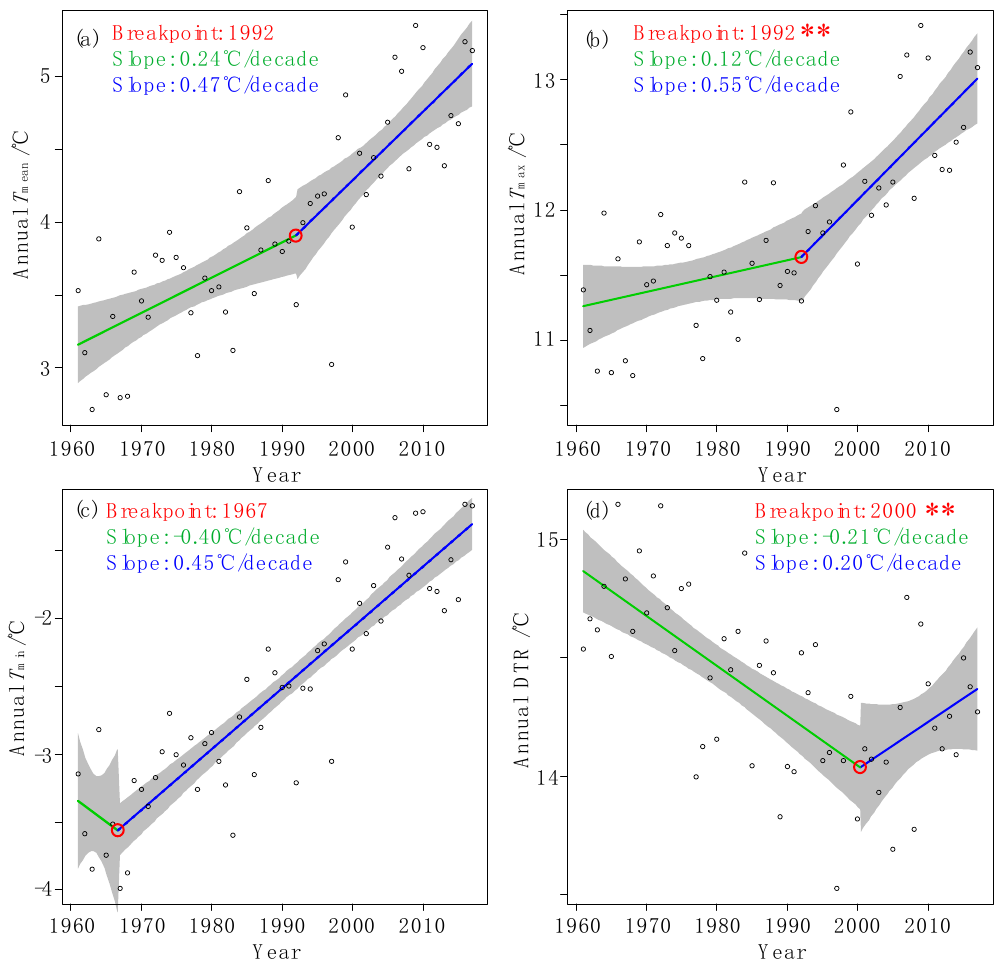
Figure 2. Change-point analysis of regional annual temperature indices on the mid-south of Tibetan Plateau during 1961 − 2017. ( a – d ) indicate the annual T mean , T max , T min, and DTR, respectively. The red circle in each panel indicates the occurrence year of change-point, and the green and blue lines represent the trends in temperature change prior to and after the change-point, respectively. Significance: *** p < 0.001, ** p < 0.01, * p < 0.05.